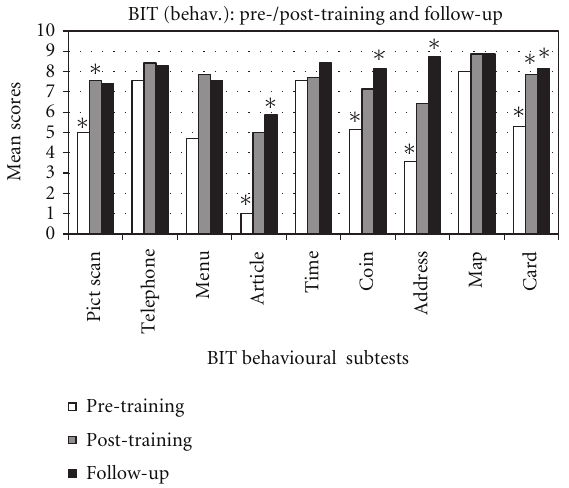
Figure 3: BIT behavioral subtests scores in the pre-/post-training and in the follow-up evaluation. ∗ Significant